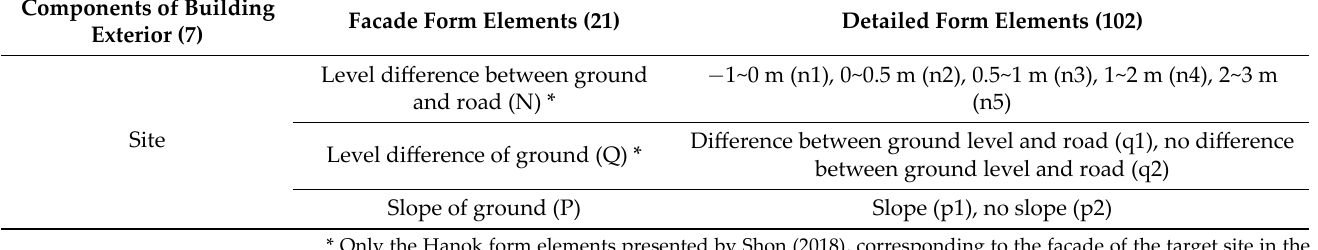
Figure 8. Location of the main gate in the plan (D) Reprinted/adapted with permission from Ref. [3]. 2018, Donghwa Shon: When the main gate is on a different elevation, the facade consists of outer walls and windows without a gate (d1). And when there is a gate, the gate is located on the same line as the wall (d2) or on the setback from the wall line (d3).